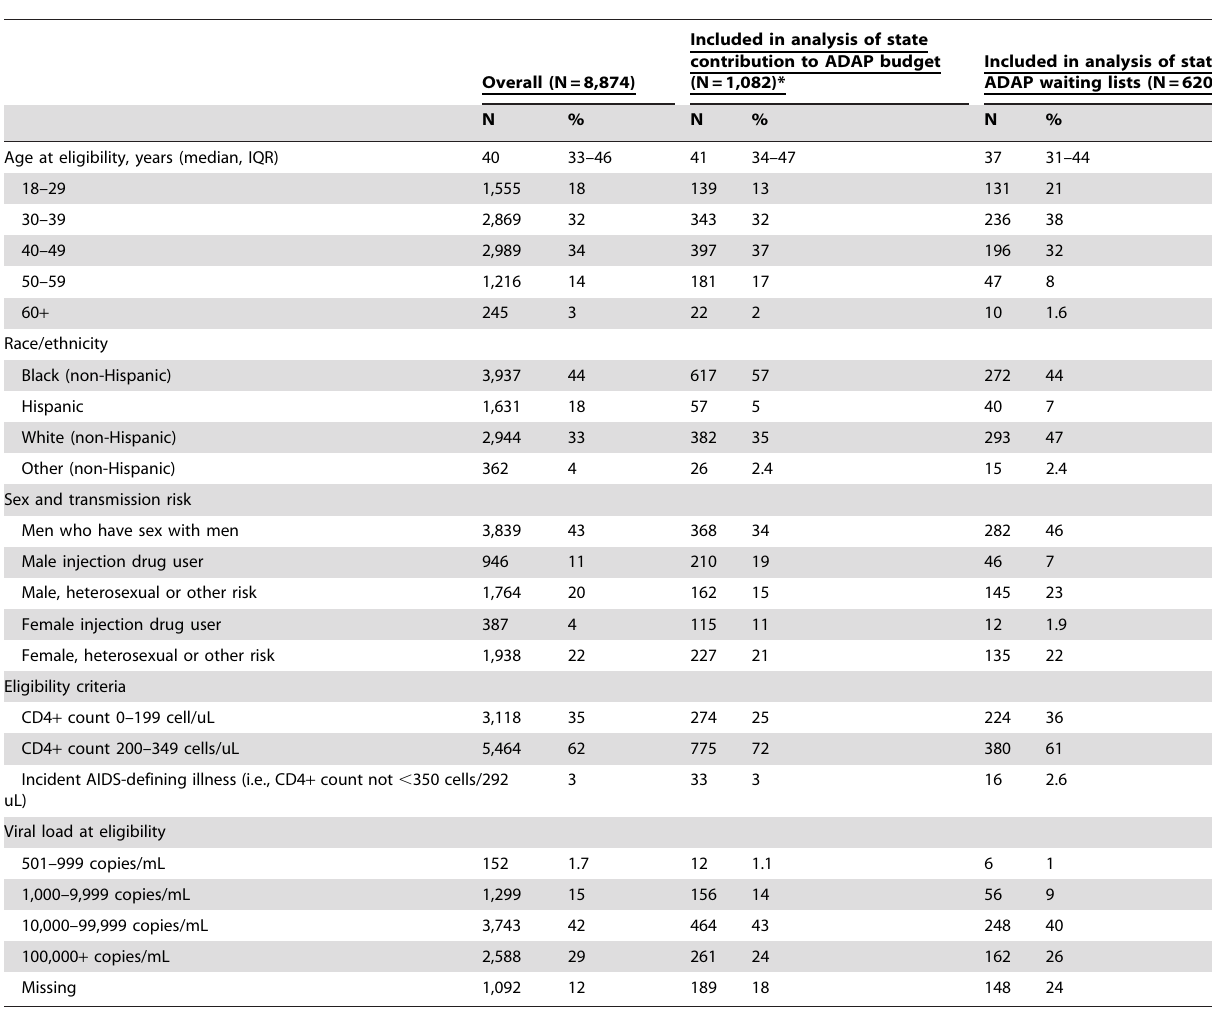
Table 2. Characteristics of newly treatment-eligible HIV-infected U.S. residents in NA-ACCORD,